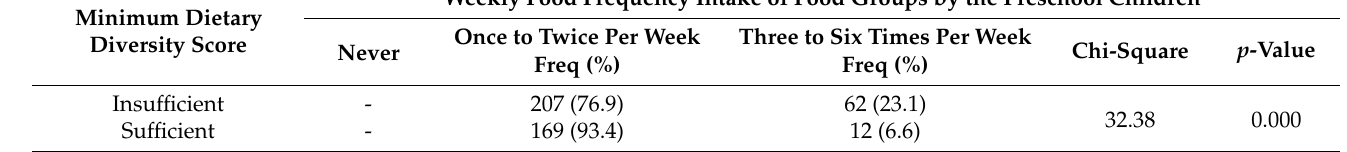
Table 4. Minimum dietary diversity intake vs. weekly food frequency consumption patterns of preschoolers.